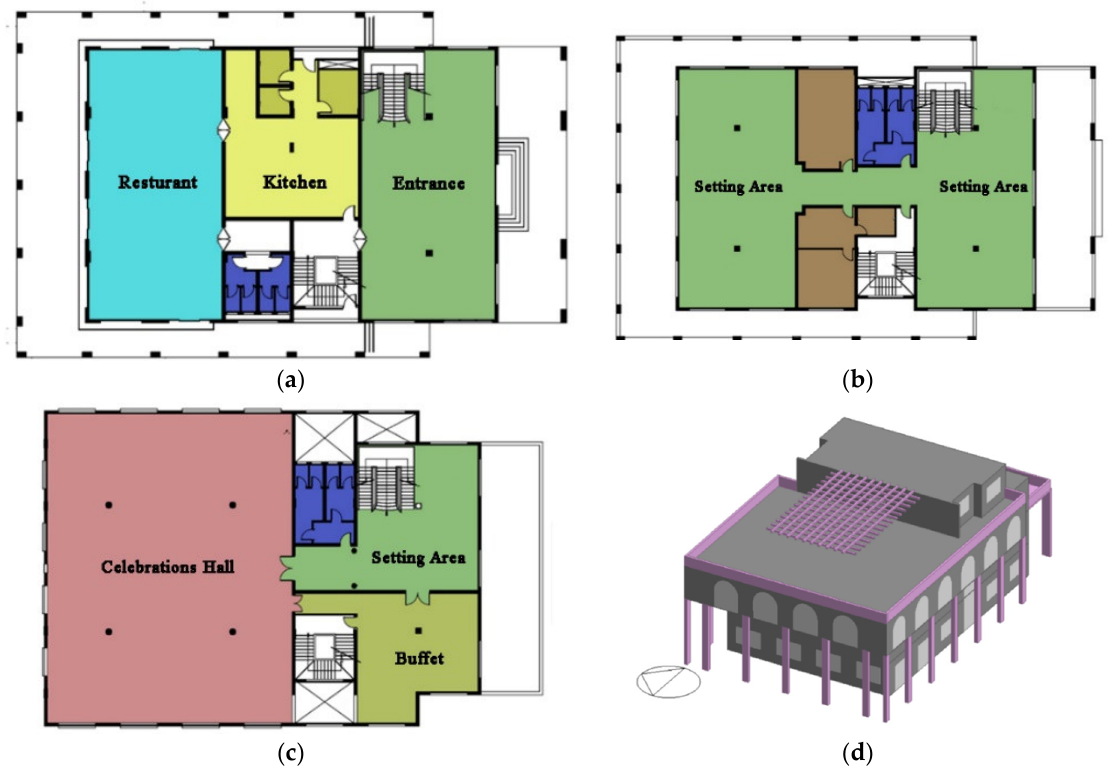
Figure 2. The building drawings: ( a ) the ground floor; ( b ) the first floor; ( c ) the second floor; ( d ) the isometric model.